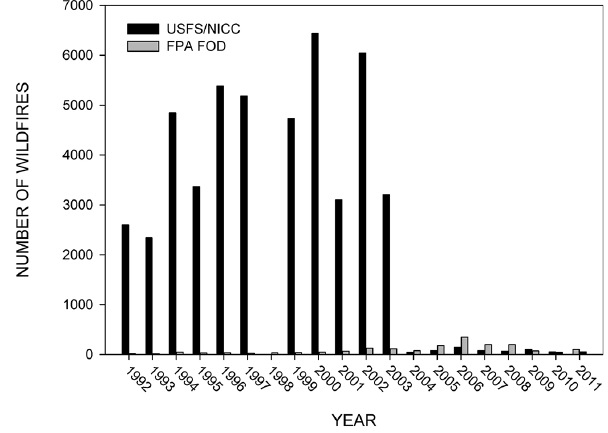
Figure 10. Number of wildfires in Kansas, 1992–2011, estimated from reference sources, per Fig. 1, and from the FPA FOD. The USFS / NICC numbers prior to 2004 indicate that an average of about 4300 wildfires occurred annually in the state during that